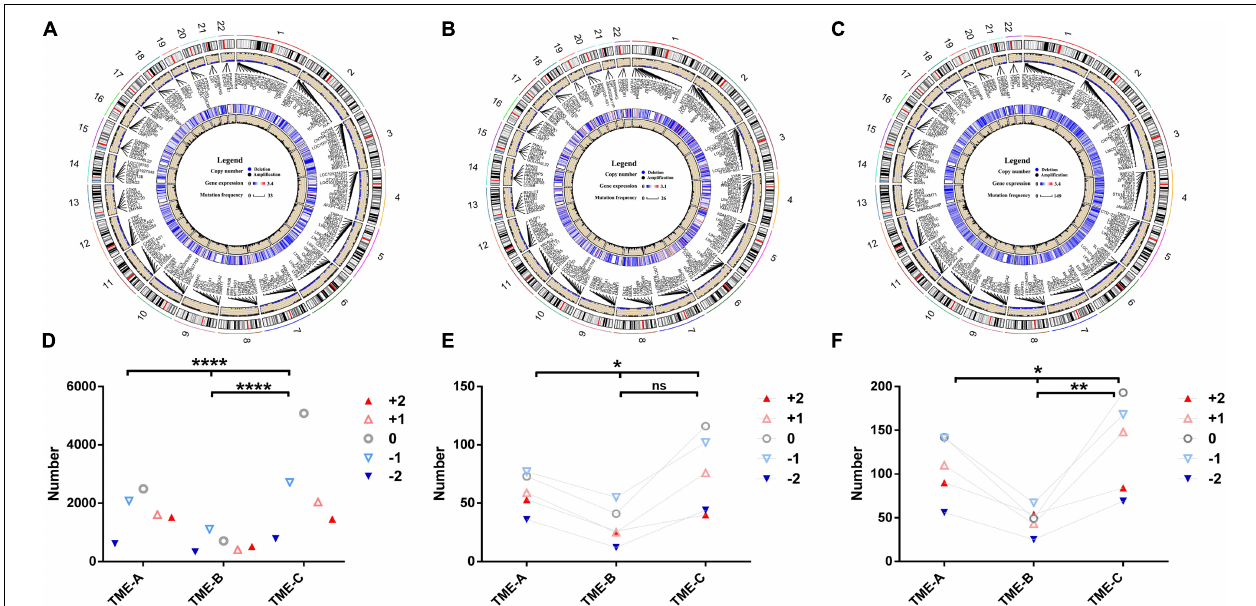
FIGURE 6 | Copy number differences among the three TME groups. (A–C) The circular visualization of copy number performance across 22 autosomes in TME-A (A) , TME-B (B) , and TME-C (C) . The outermost ring represents the human chromosome data. The scatter plot represents the CNV labeled with several annotated representative genes symbols. Blue dots denote deletion, black dots denote amplification, and null denotes that there is no CNV. The heatmap represents the mean expression levels of annotated genes. The line plot represents the frequency of annotated genes. (D) The mutation number of different CNVs among three TME groups. (E) The mutation number of different CNVs annotated to genes that are upregulated in the TME-B versus TME-C. (F) The mutation number of different CNVs annotated to genes that are downregulated in the TME-B versus TME-C (**** P < 0.0001, *** P < 0.001, ** P < 0.01, * P < 0.05, ns: no significance; +2: homozygous deletion, -1: single copy deletion, 0: diploid normal, +1: low-level amplification, +2: high-level